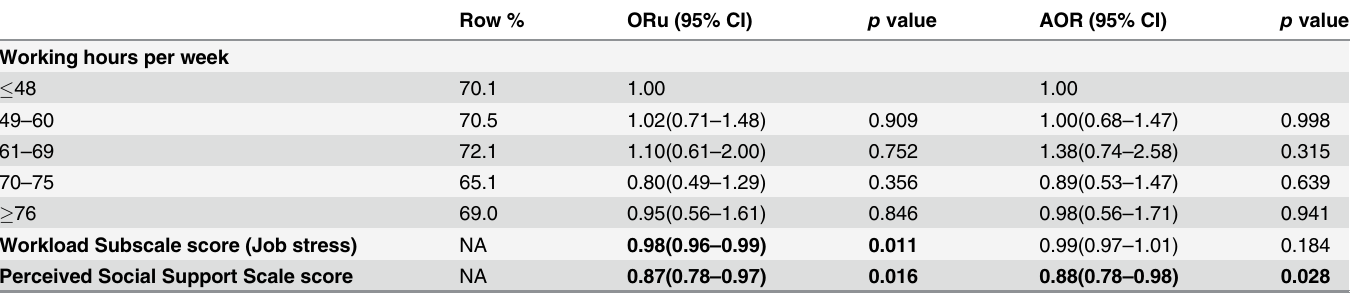
Table 3. Work hour, perceived job stress due to workload and perceived social support as associated factors of “ a very low level of physical activ- ity ” (i.e. having (cid:1) 30 minutes of moderate or rigorous physical activity in the last